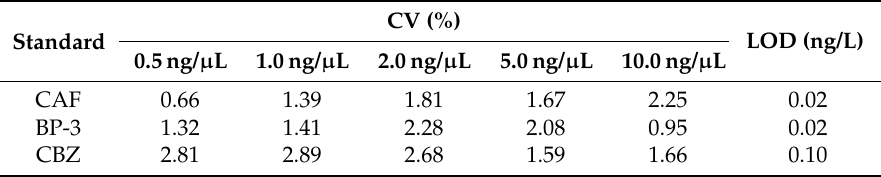
Table 4. Coefficient of Variation (CV) for five concentration levels of tested micropollutants.